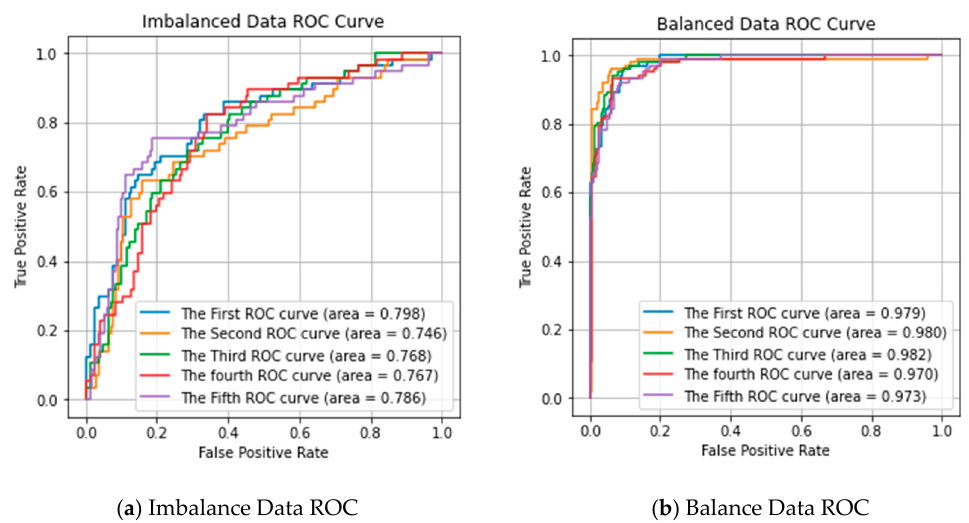
Table 1. DeepPred-SubMito structure parameters. Figure 1. Receiver Operating Characteristic (ROC) curve of our proposed predictor performance in imbalanced data and balanced data. ( a ) Imbalance Data ROC; ( b ) Balance Data ROC.